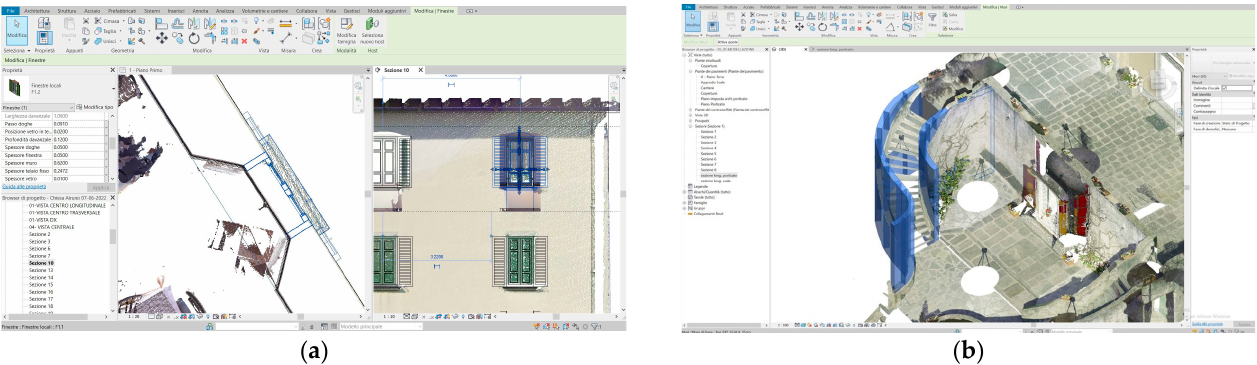
Figure 9. ( a ) The window nested model; ( b ) the stairs from the sepulchre chapel to the upper floor. For the modelling of exteriors, different types of loadable families were generated, taking as reference the “Portico Columns” family, used for the columns that follow the perimeter of the entire portico. The different components of the column are modelled, such as shaft, capital, and base, each bound to reference planes useful for creating parameters. The loaded "Portico Columns" family was used to model all the columns along the perimeter of the external portico, duplicated and renamed for each column. The type was modified through the parameters previously created. Therefore, within the working project, one has a single family for these components and a series of different types relating to each column, renamed and customized. The holy staircase (Figure 10a,c) hosts the aedicule shown in Figure 10b. It was modelled as a system family, with thirteen copies inserted within the project, which are modifiable according to the specific characteristics of each.